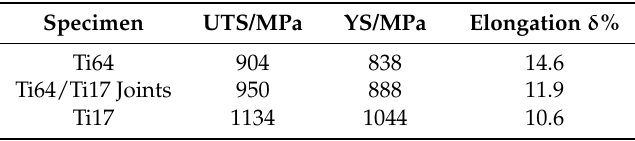
Table 2. Tensile properties of base metals and joints.